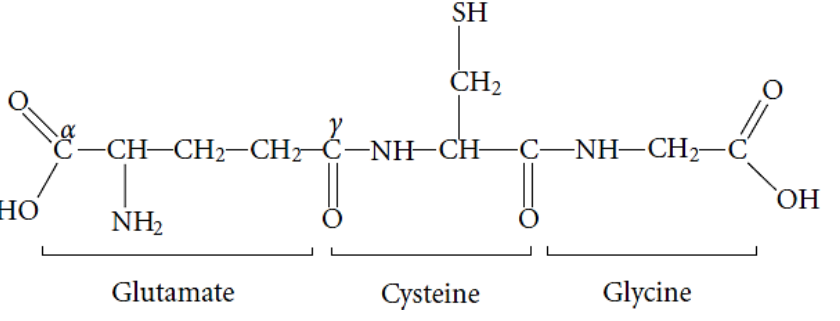
Figure 5. The reduced form of glutathione (GSH).